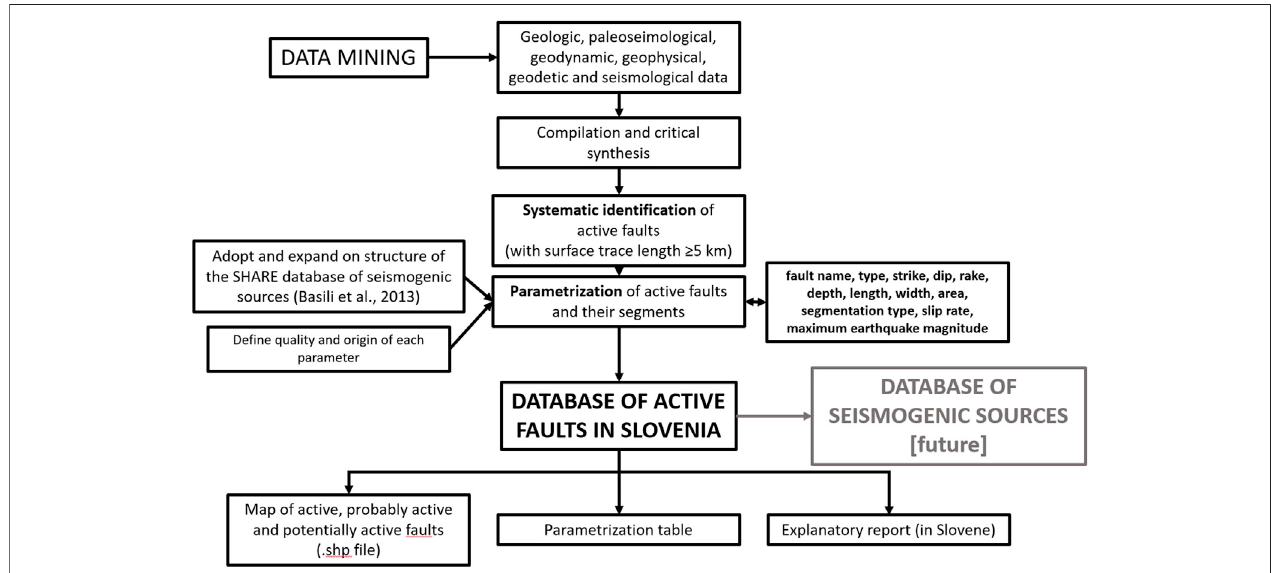
FIGURE 3 | Active fault map and database compilation work fl